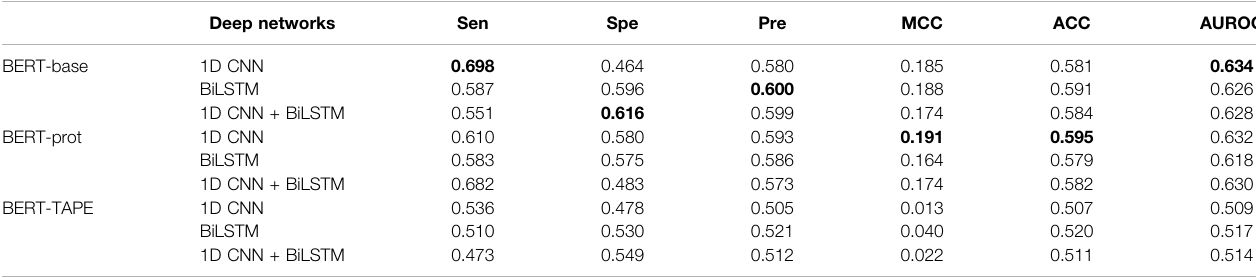
TABLE 2 | Cross-validation performance of models based on embeddings of the central “ K ” extracted from different pretrained BERT models. Deep networks Sen Spe Pre MCC ACC AUROC BERT-base